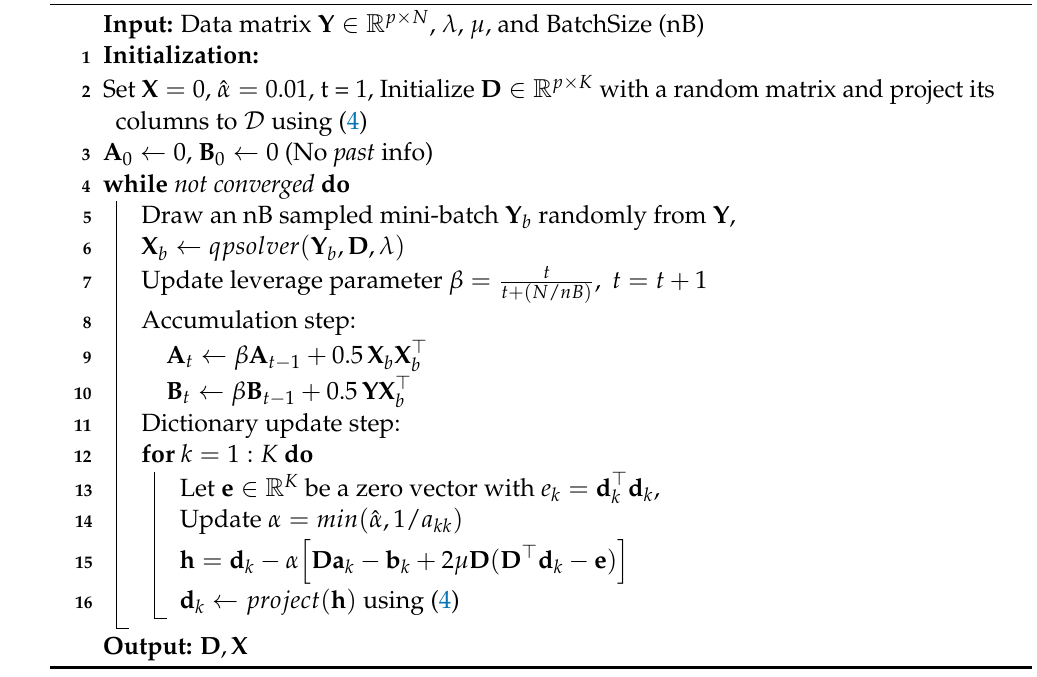
Algorithm 2: A2: Online incoherent dictionary learning